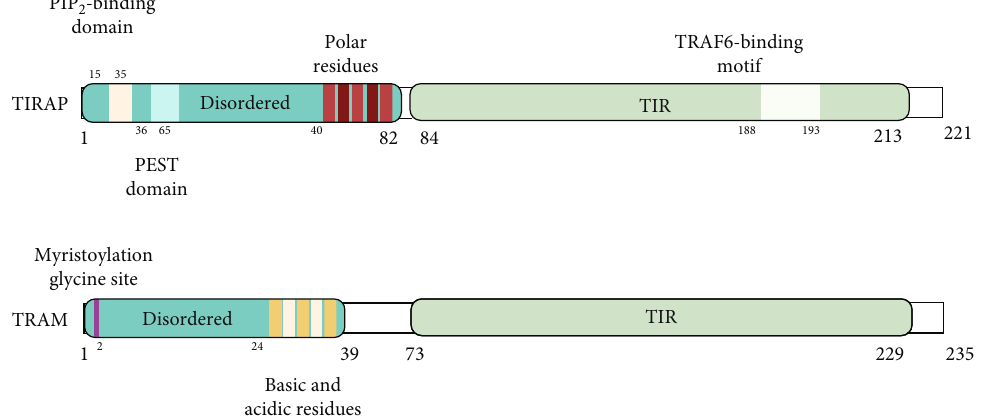
Figure 2: Structural view of human TIRAP and TRAM adaptor proteins. TIRAP contains a N-terminal PIP domain, allowing polyubiquitination for rapid proteasomal degradation through suppressor of cytokine signaling 1 (SOCS1) binding [20]. TIRAP contains a C-terminal TIR domain. Its TRAF-6 binding motif permits direct association with TRAF6 for activation [21]. TRAM contains a N-terminal bipartite sorting signal that comprises its myristylation glycine site and controls its tra ffi cking between the plasma membrane and the endosomes [22]. Similar to TIRAP, TRAM contains a C-terminal TIR